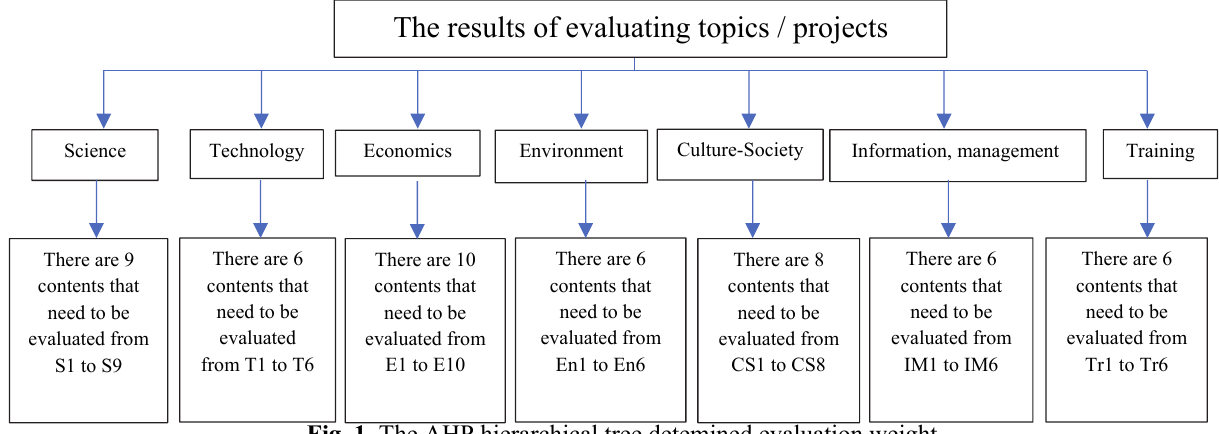
Fig. 1. The AHP hierarchical tree detemined evaluation